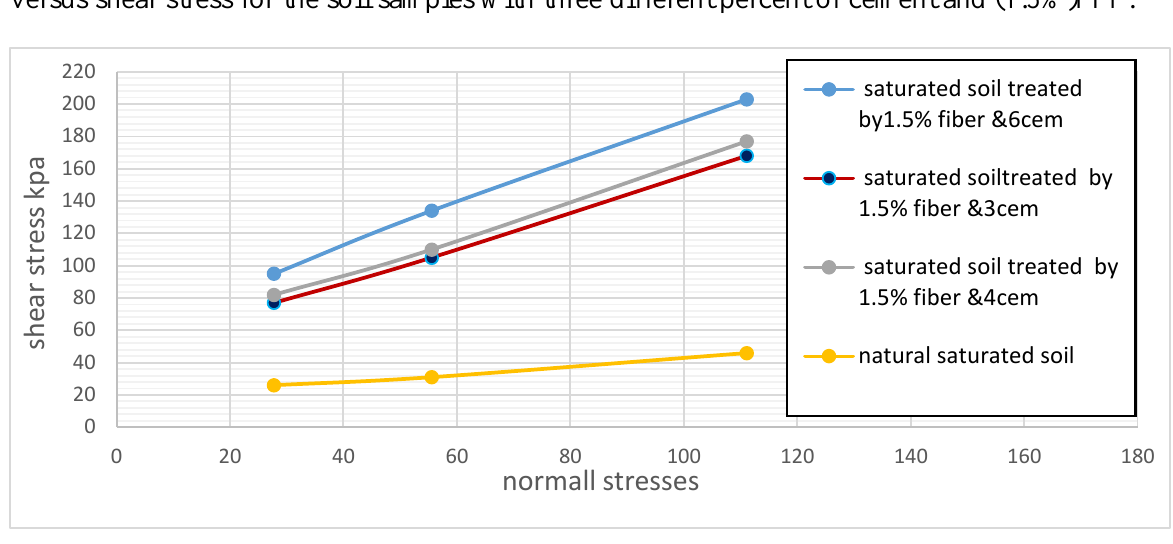
Fig. 11. Relationship between normal stresses and shear stress for treated soil with (PPF) and cement, from direct shear test in dry and soaked condition. Table. 4. The results of shear strength parameters before and after adding the additives. treated